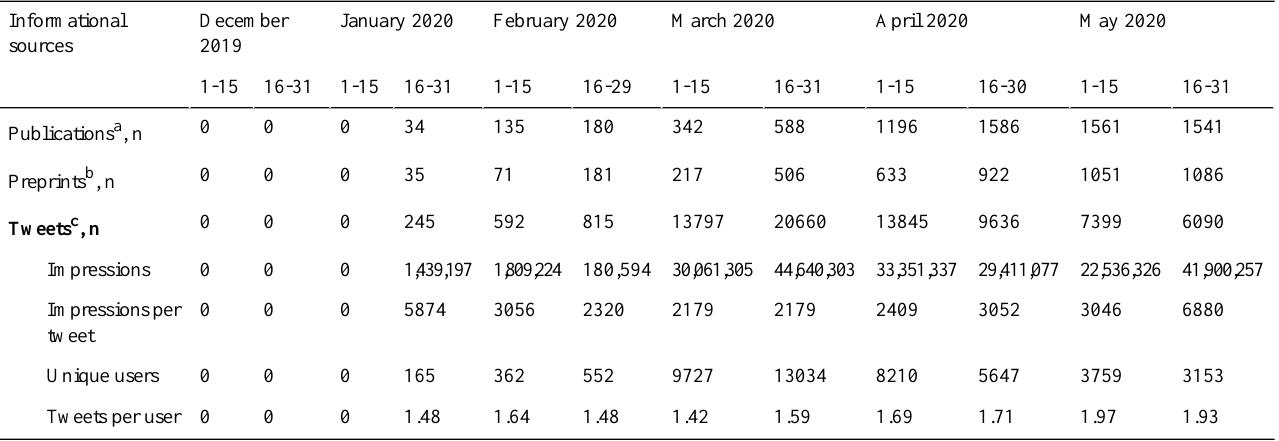
Table 1. A comparison of productivity trends by half-month intervals of COVID-19–related publication, preprint, and Twitter activity from